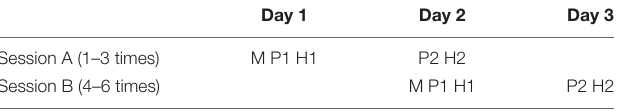
TABLE 2 | The learning times and learning procedure for each type of